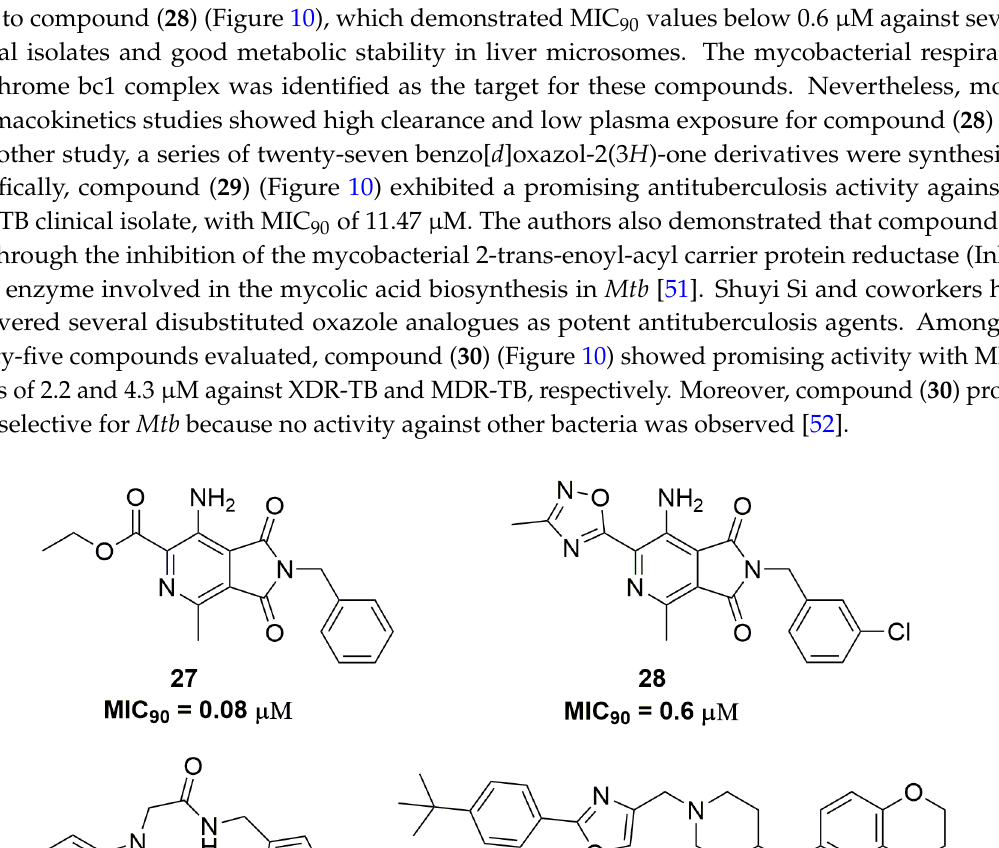
Figure 10. Heterocyclic compounds as promising agents for the treatment of MDR-TB.